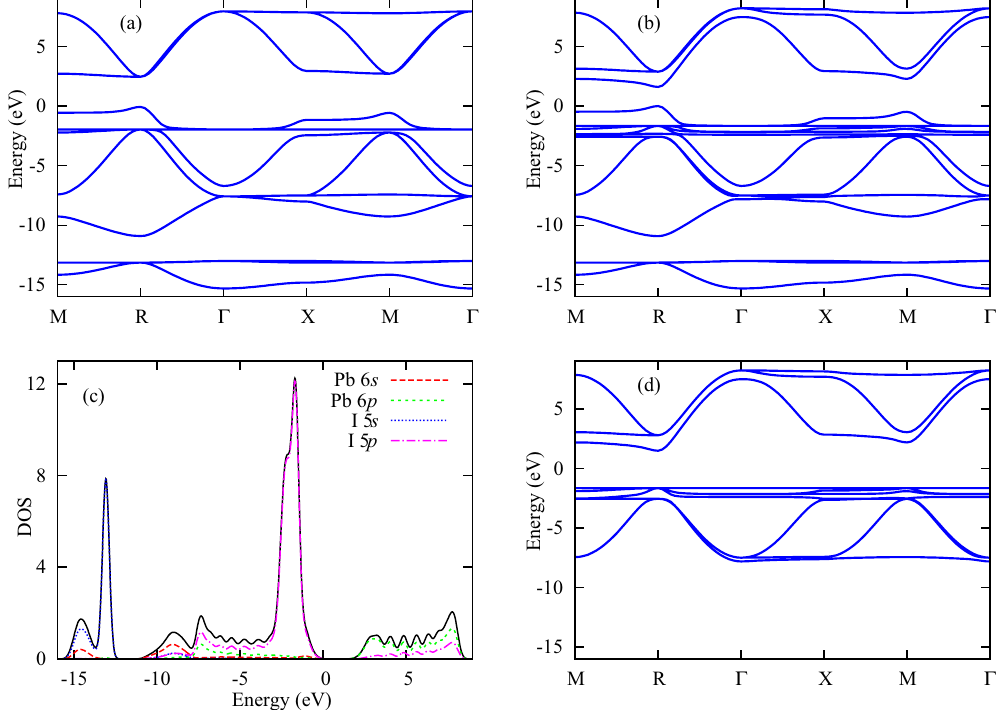
Figure 2. Band structure of the tight-binding model without SOC ( a ) and including SOC ( b ). The quasi- momentum points marked on the x axis are Γ = (0, 0, 0), X = (0.5, 0, 0), M = (0.5, 0.5, 0), and R = (0.5, 0.5, 0.5) [in units of 2 π / a , where a is the lattice constant]. From ( b ) we calculate the density of states (DOS) per unit cell, which we plot in ( c ) (solid black line) along with the contributions of the different orbitals in the model: Pb 6 s (red dashed line), Pb 6 p (green short-dashed line), I 5 s (blue dotted line) and I 5 p (magenta dash-dotted line). In ( d ) we plot the band structure that we would obtain if we keep only the p orbitals in the model, i.e. remove from the Hamiltonian all matrix elements related to the s orbitals. Note that all of the plots in this figure are obtained using calculations on a single unit cell and not our 8 × 8 × 8 supercell. For the DOS we take 8000 quasi-momentum points distributed uniformly in the first Brillouin zone, and we replace each energy level by a Gaussian peak of width 0.2 eV, which is chosen to produce a smooth curve rather than a large number of narrow